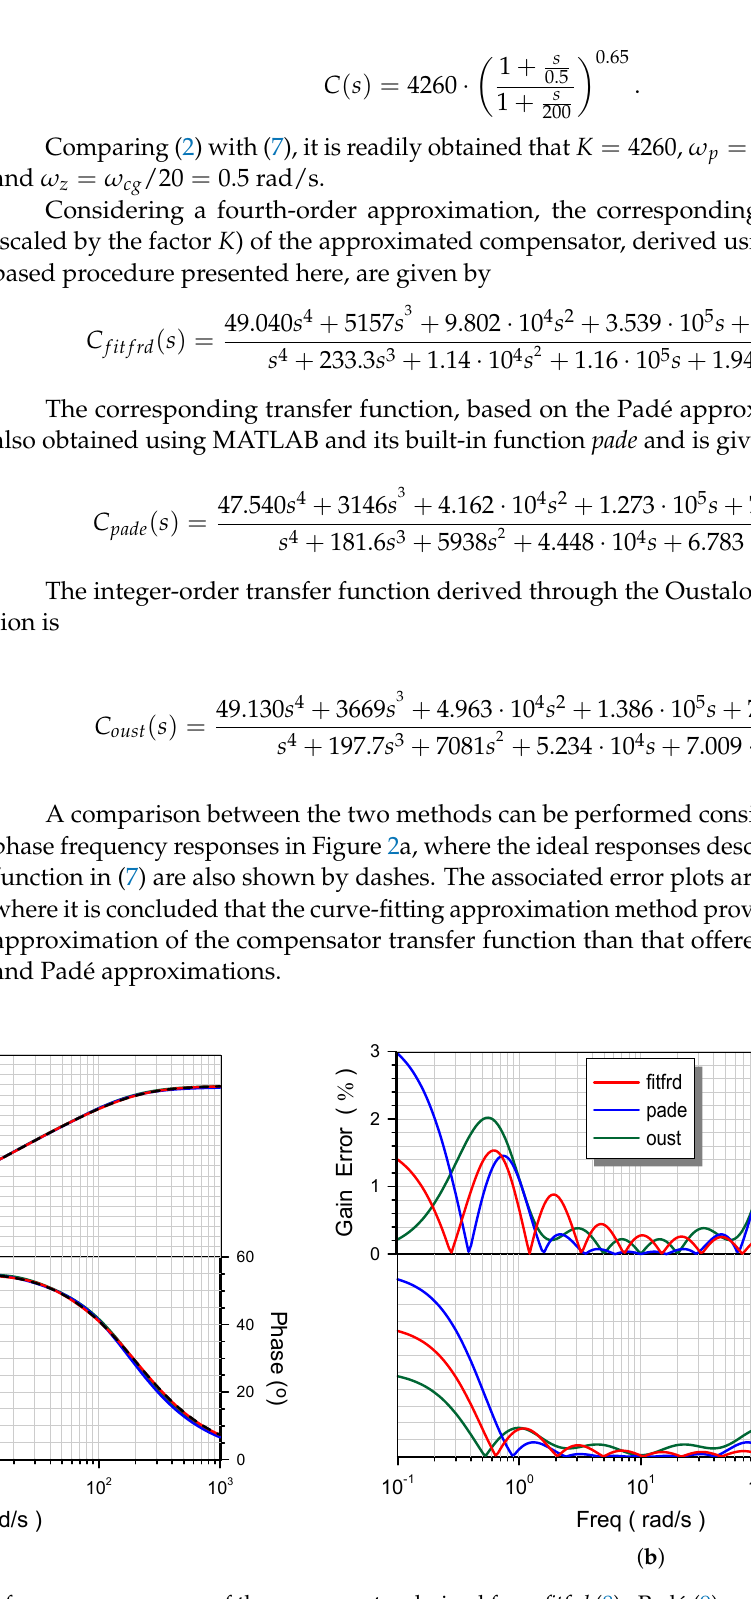
Figure 2. ( a ) Gain and phase frequency responses of the compensator derived from fitfrd (8), Padé (9), and Oustaloup (10) approximation methods along with the ideal responses derived from (7) and ( b ) the relative errors for each